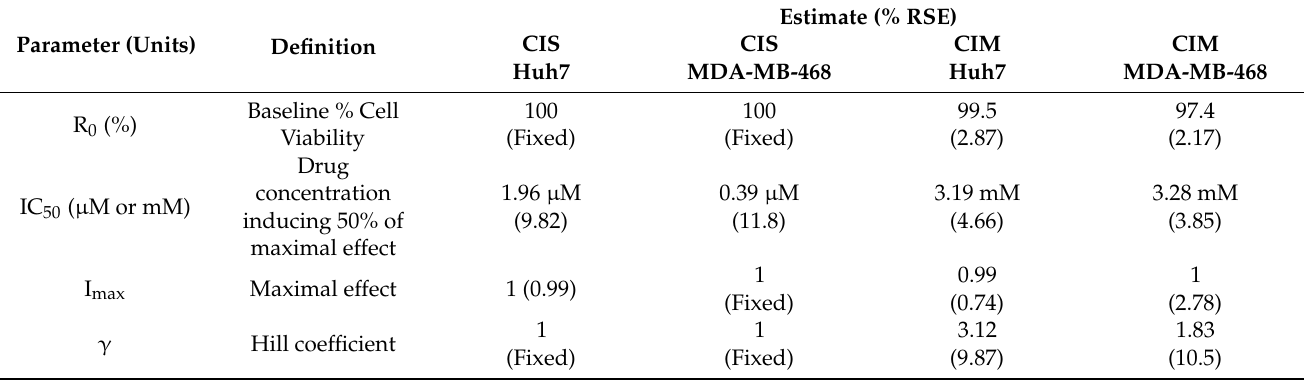
Table 1. Concentration-response curve parameter estimates for CIS and CIM as single agents in